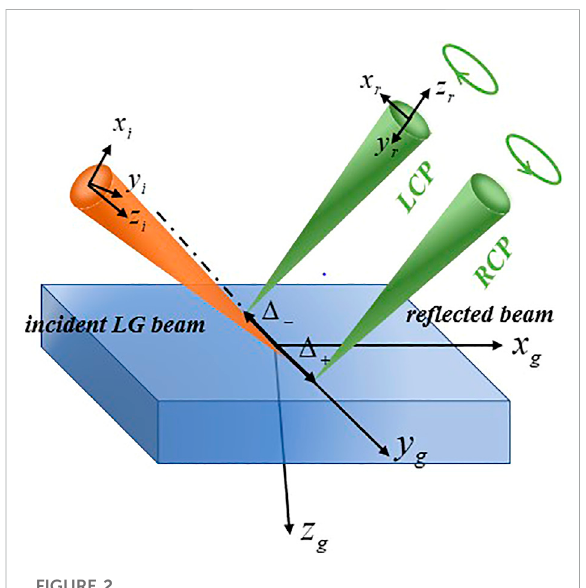
FIGURE 2 Spin splitting phenomenon schematic of Gaussian